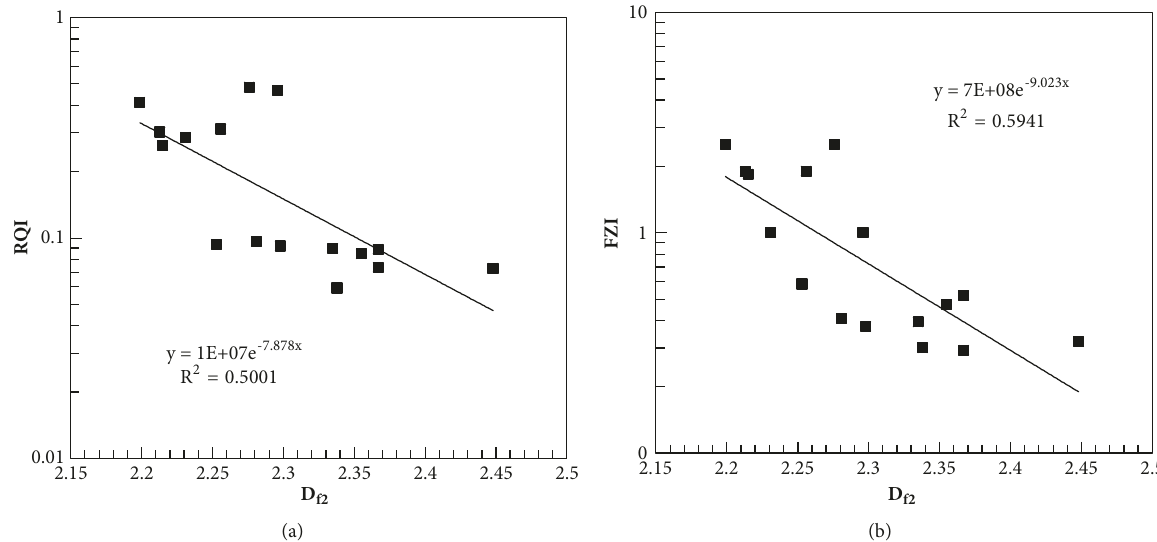
Figure 8: Relationship between fractal dimensions of the entire pores 𝐷 𝑓2 and RQI (a) and FZI (b).